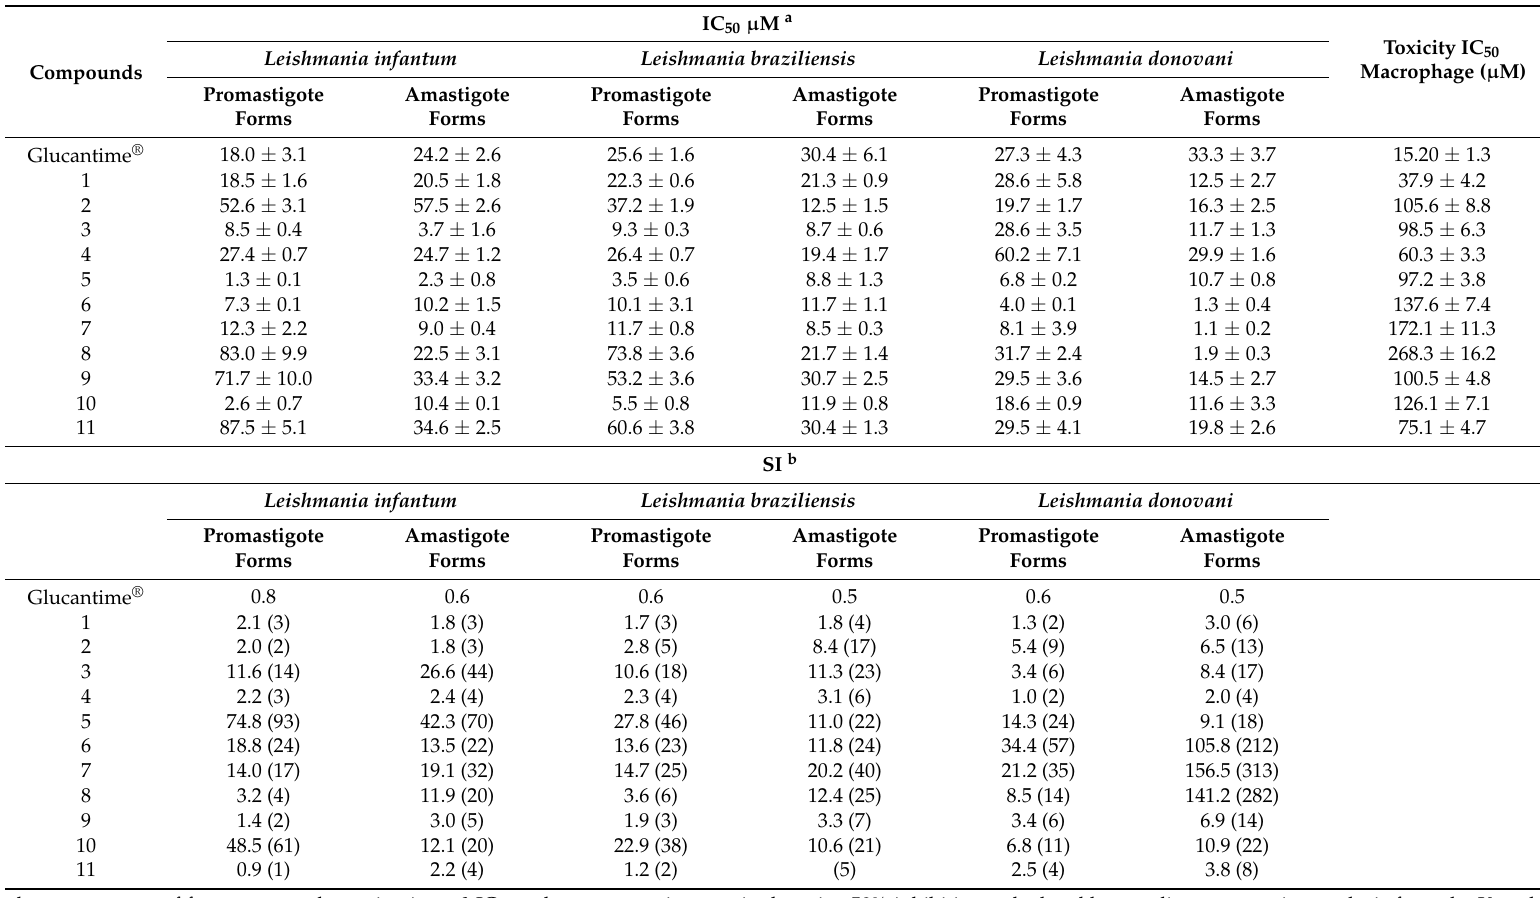
Table 1. In vitro activity, toxicity ( A ) and selectivity index ( B ) found for the polyaminic compound complexes on extracellular and intracellular forms of Leishmania spp.